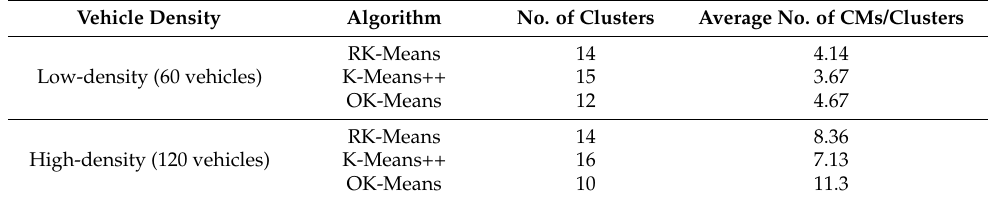
Table 6. Average cluster distribution.